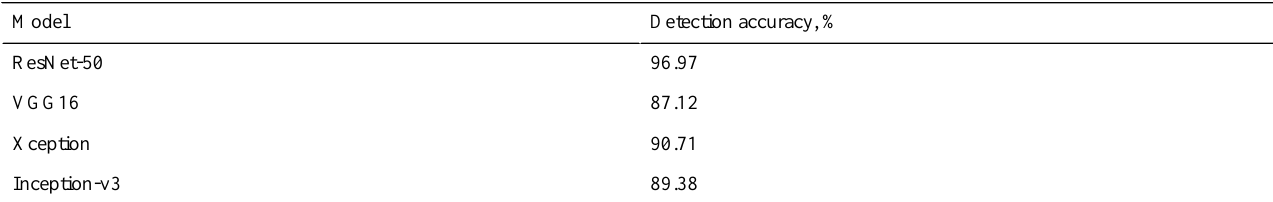
Table 5. Performance of each deep learning model on the additional external validation data set of COVID-19 pneumonia images.